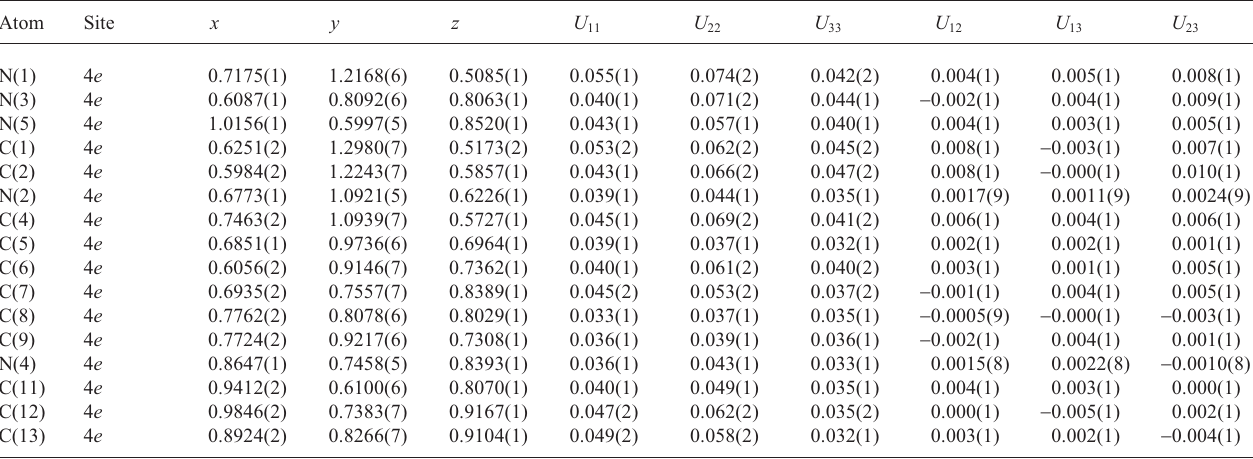
Table 3. Atomic coordinates and displacement parameters (in Å 2 )